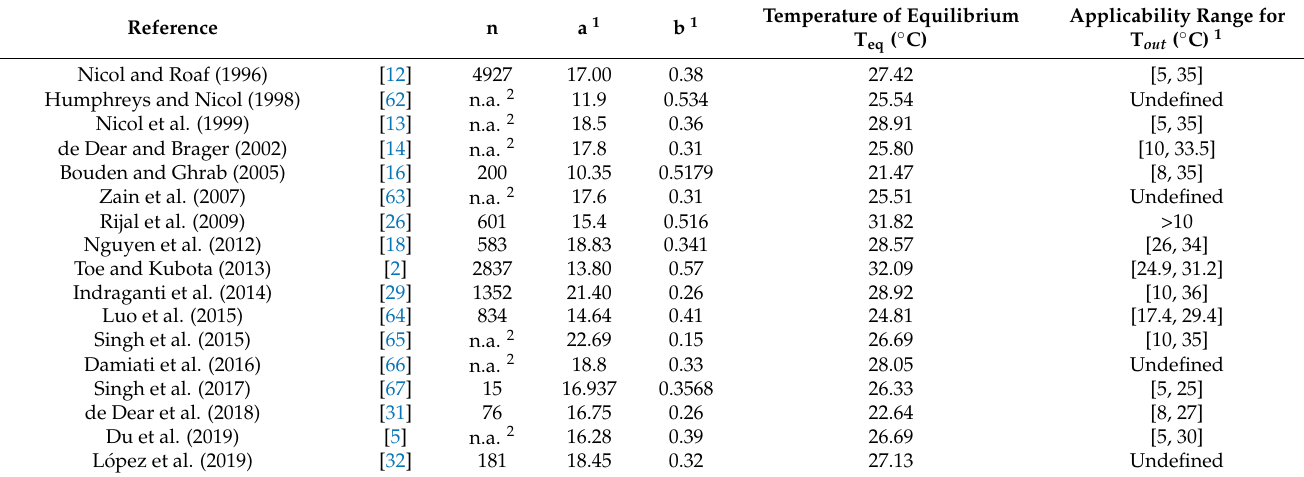
Table 1. Parameters of the equations of thermal comfort in a hot-humid